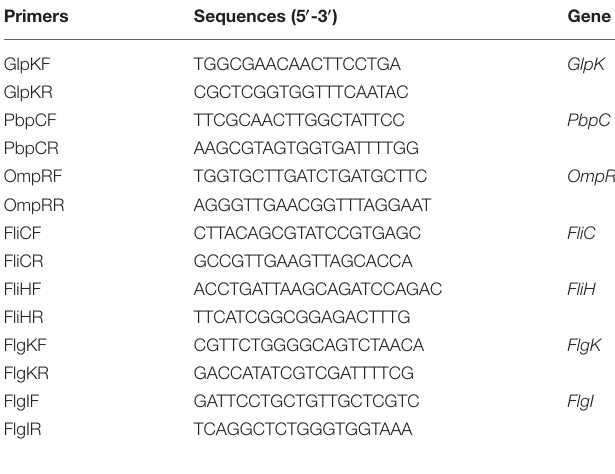
TABLE 1 | Primers used for real-time quantitative PCR (RT-qPCR)